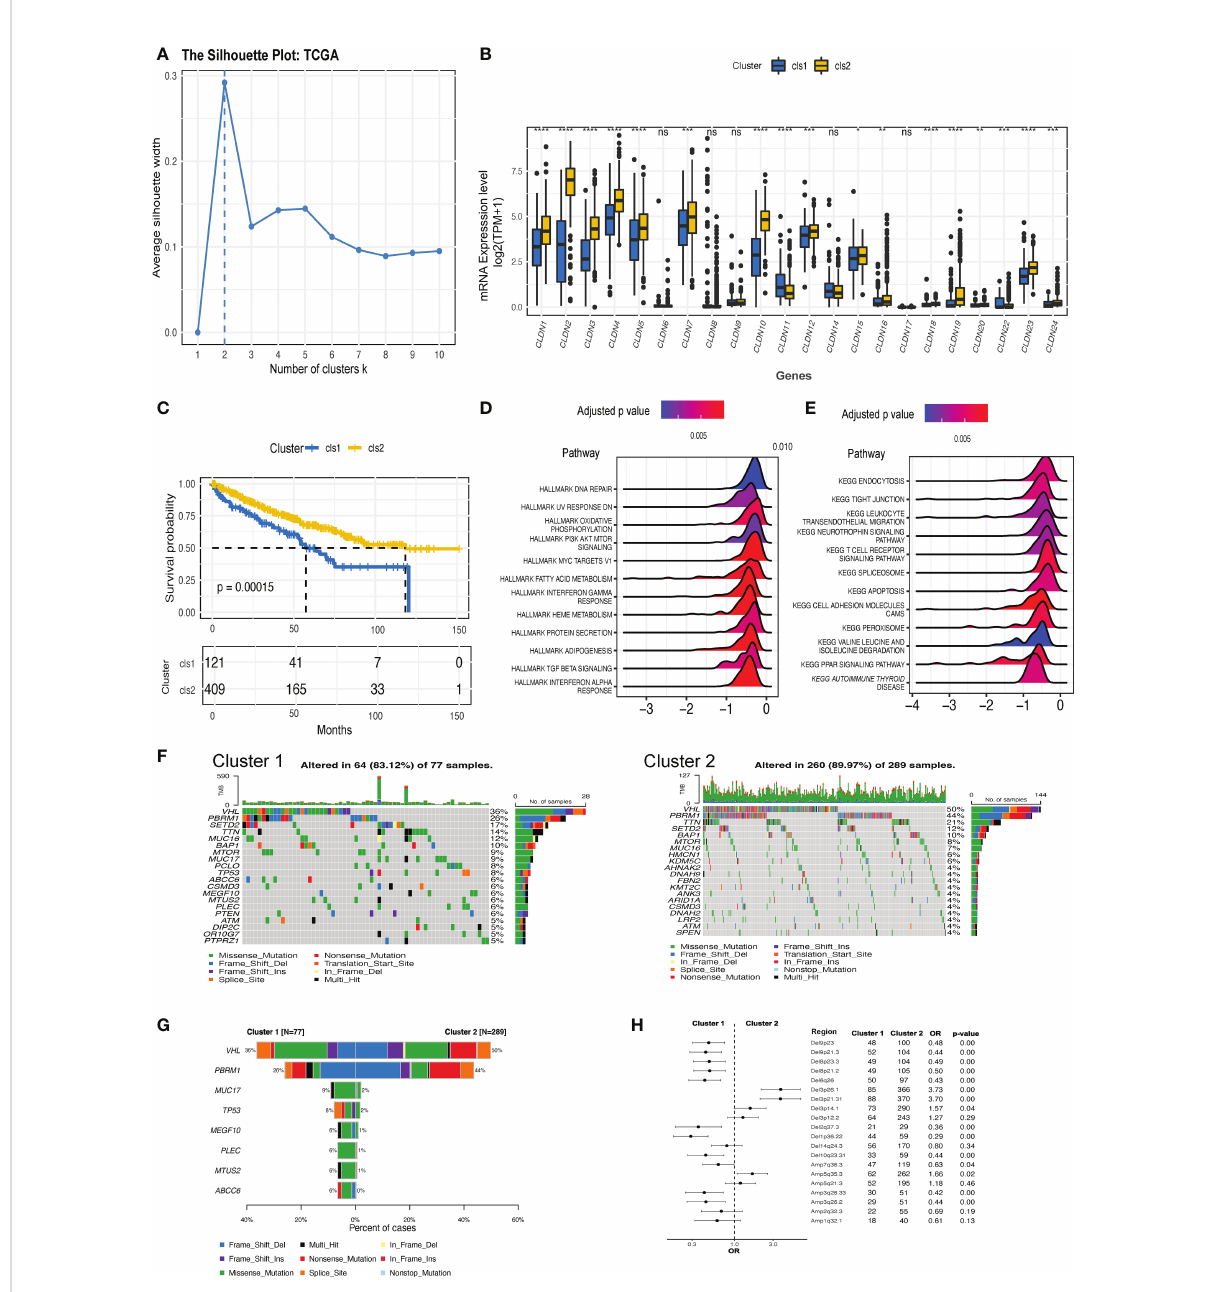
FIGURE 2 The expression clusters of claudin genes in ccRCC. (A) Silhouette clustering analysis in The Cancer Genome Atlas-kidney clear cell carcinoma (TCGA-KIRC) cohort. (B) The difference in the expression level of each claudin gene between clusters 1 and 2. (C) Kaplan – Meier estimates of the difference in the overall survival between cluster 1 and cluster 2. Hallmark (D) and Kyoto Encyclopedia of Genes and Genomes (KEGG) (E) pathways analysis revealed the pathways signi fi cantly enriched in the differentially expressed genes (DEGs) between the two clusters. (F) Oncoprints of the top 20 prevalent genes in cluster 1 (left) and cluster 2 (right). (G) Genes with signi fi cantly differed prevalence in cluster 1 or cluster 2. Only genes with a prevalence of over 3% in at least one cluster were analyzed. (H) Difference in the prevalence of copy number variants (CNV) between clusters 1 and 2. OR value below 1 is indicated as more prevalent in cluster 1. Del, deletion; Amp, ampli fi cation; OR, odds ratio; TPM, transcript per million. *p<0.05, **p<0.01, ***p<0.001, ****p<0.0001. ns, not signi fi